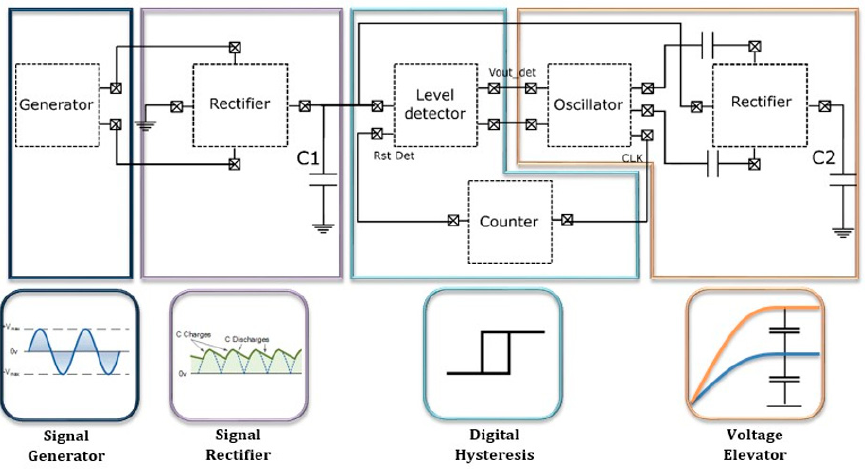
Figure 3. Schematic of converter circuit, showing the different function block.